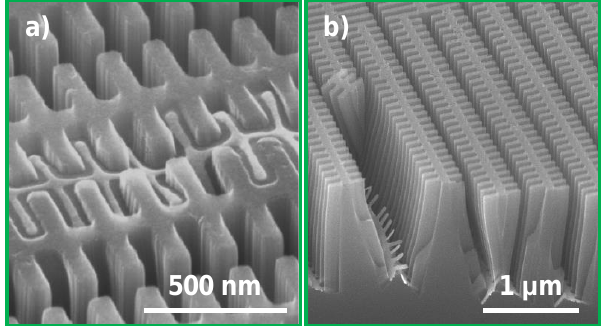
Figure 5. Fishbone zone plate catalyst etched at MACE condition C2. SEM micrographs show ( a ) local etching differences (6 min MACE) and ( b ) non-vertical etching (12 min MACE). The cross-section in ( b ) was prepared by manual